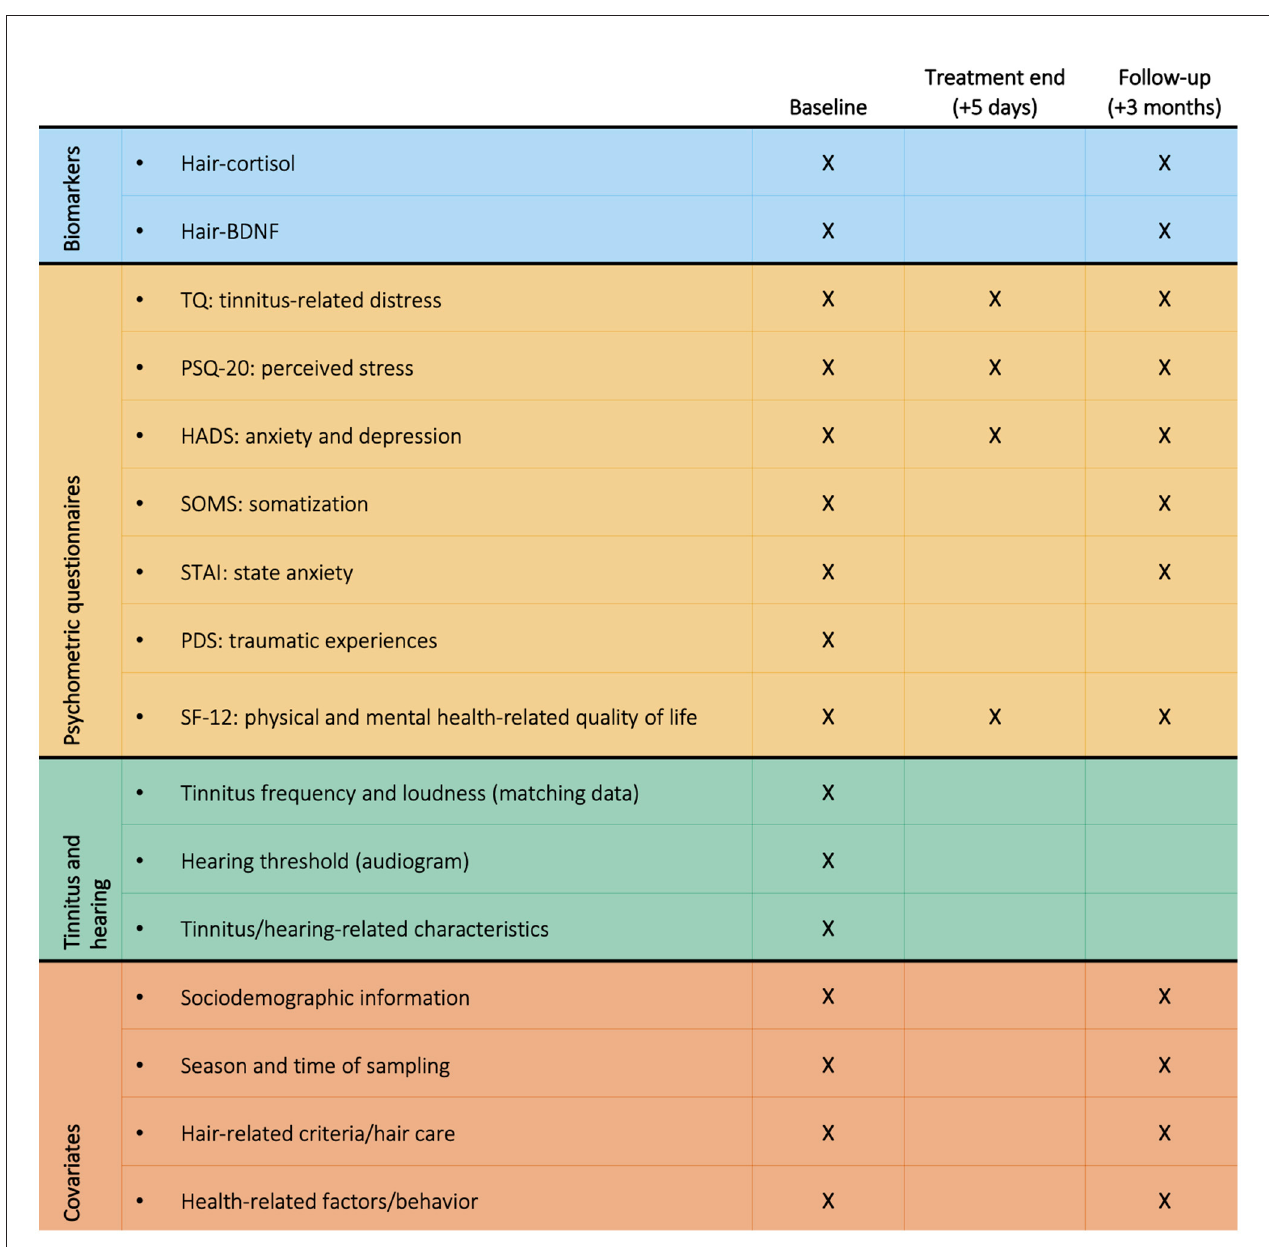
FIGURE 1 | Overview of all collected study variables across measurements (baseline, treatment end, and follow-up). BDNF, Brain-Derived Neurotrophic Factor; HADS, Hospital Anxiety and Depression Scale; PDS, Posttraumatic Diagnostic Scale; PSQ-20, Perceived Stress Questionnaire (20 item version); SF-12, Short Form-12 Health Survey; SOMS, Screening of Somatoform Disorders; STAI, State-Trait Anxiety Inventory (State Anxiety); TQ, Tinnitus